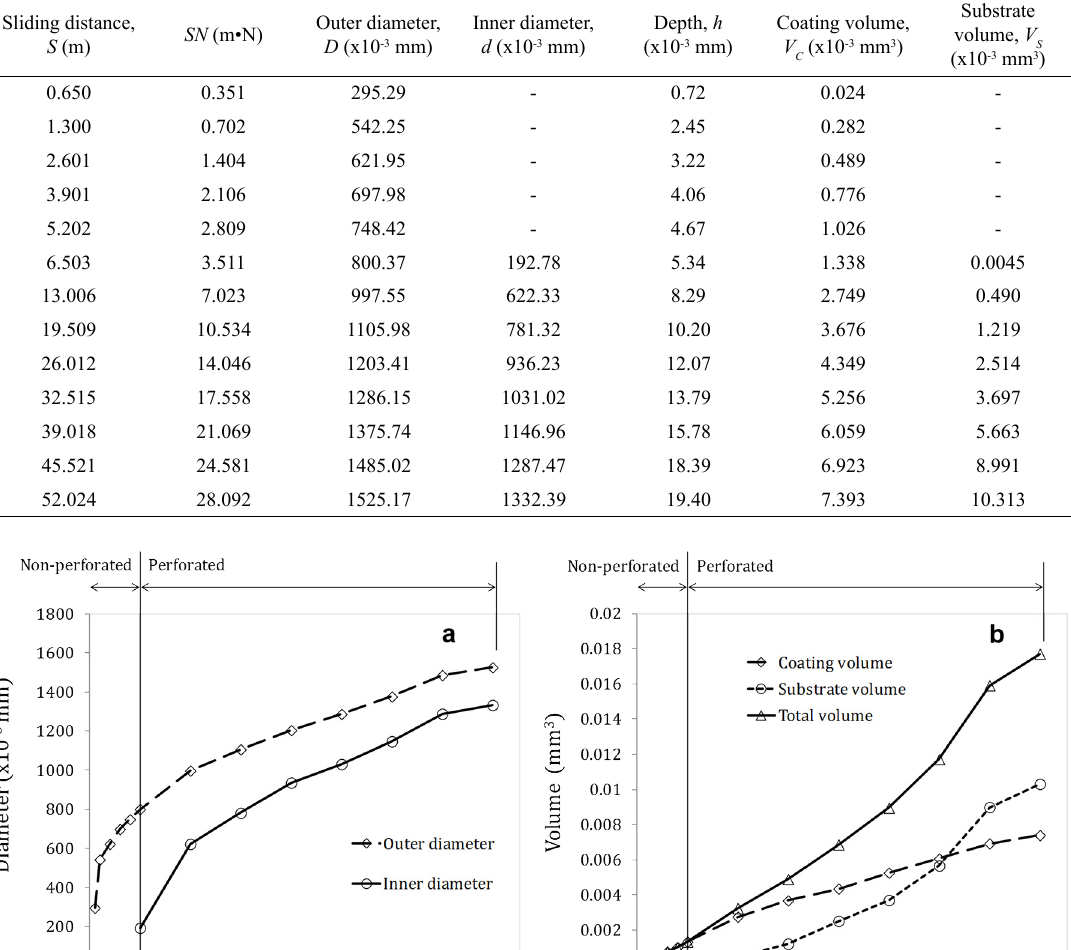
Table 3. Summary of micro-abrasive wear measurements: ball radius 15 mm, N = 0.54 N. Sliding distance, S (m)